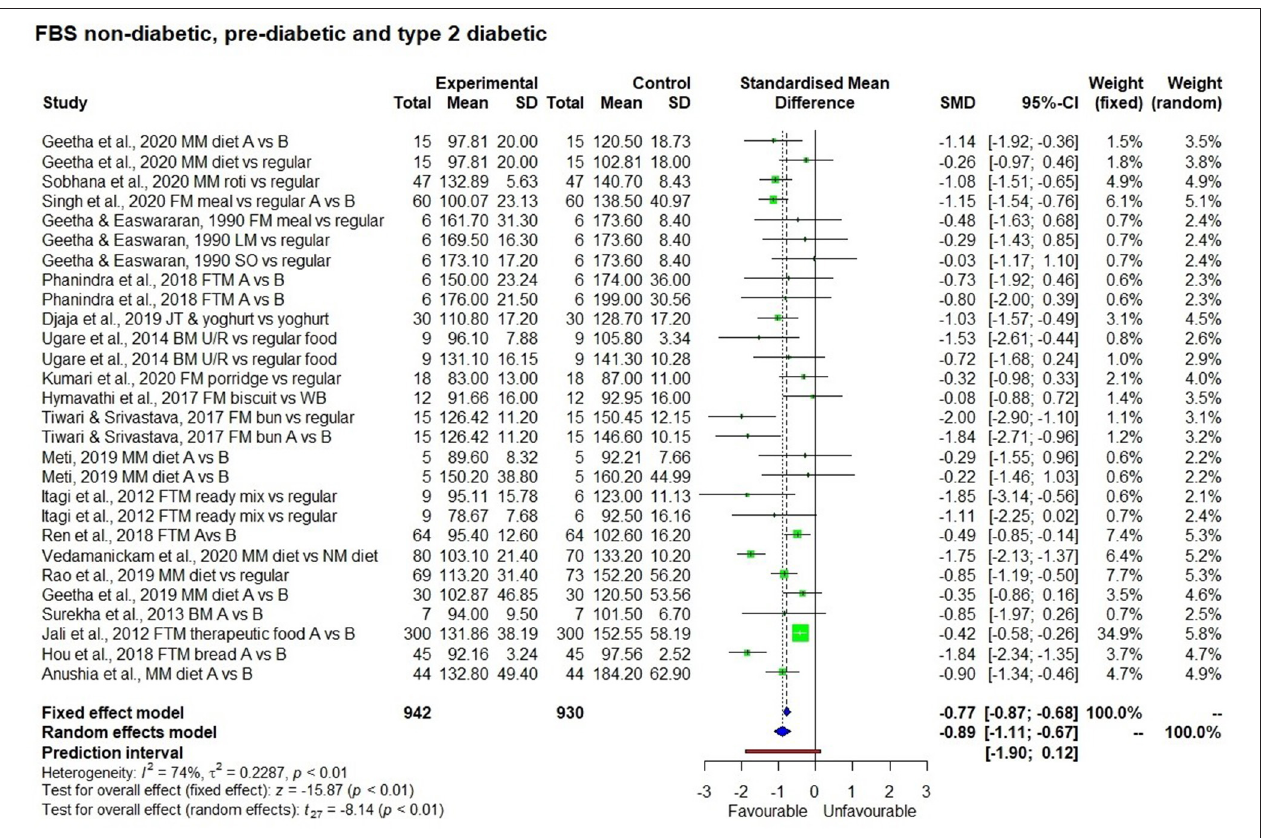
FIGURE 5 | Effect of long term consumption of millet on fasting blood glucose levels in non-diabetic, pre-diabetic, and diabetic subjects compared to the control group consuming a regular diet or pre vs post intervention comparison.